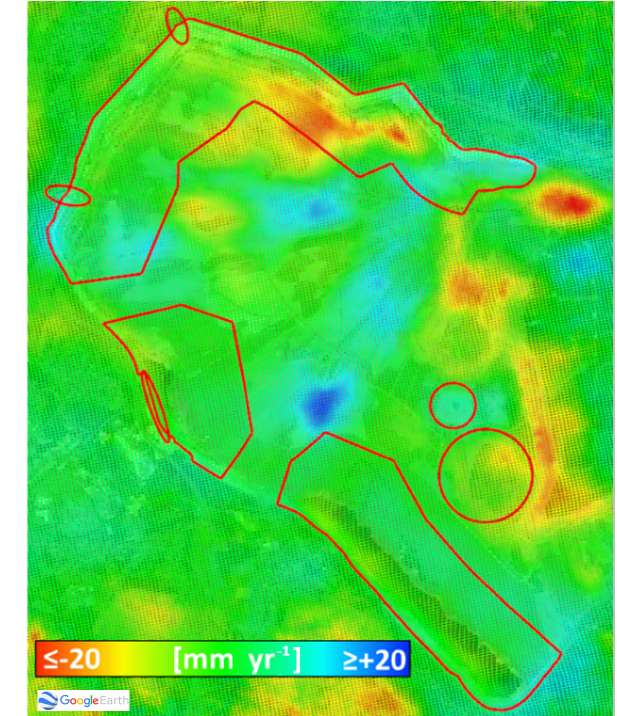
Figure 4. DSI vertical velocity at open-pit test mine (14 ◦ 25 (cid:48) 21 . 14 (cid:48)(cid:48) E, 51 ◦ 47 (cid:48) 1 . 56 (cid:48)(cid:48) N) (Fig. 2). Negative and pos- itive, subsidence and heave. Red enclosed area, priority area (© Google Earth).